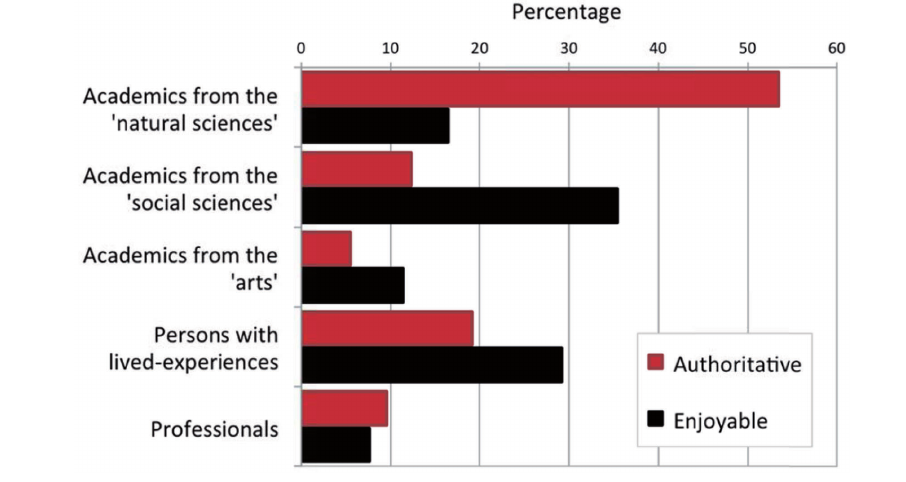
Figure 4: Response to participant survey Attendees were asked which category of expert they found (1) most authoritative and (2) most enjoyable. Data were collected from 73 and 79 survey respondents,